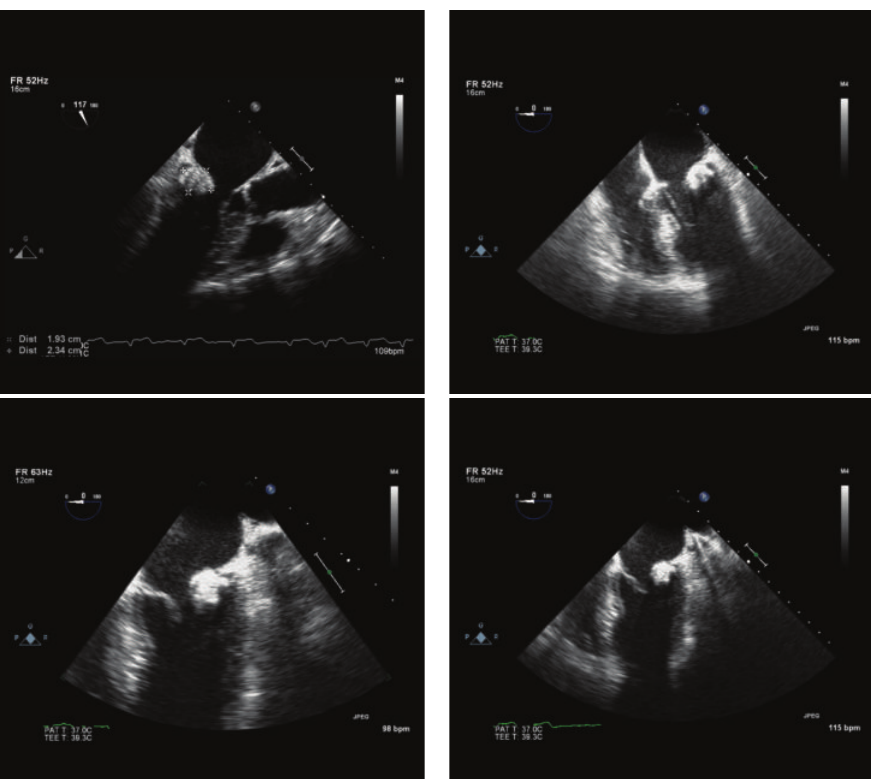
Figure 2: Transesophageal echocardiogram views. Four standard views that show a well-circumscribed echogenic mass that measures 19 × 23 mm and appears to be attached to mitral annulus and extending into the posterior mitral valve leaflet.